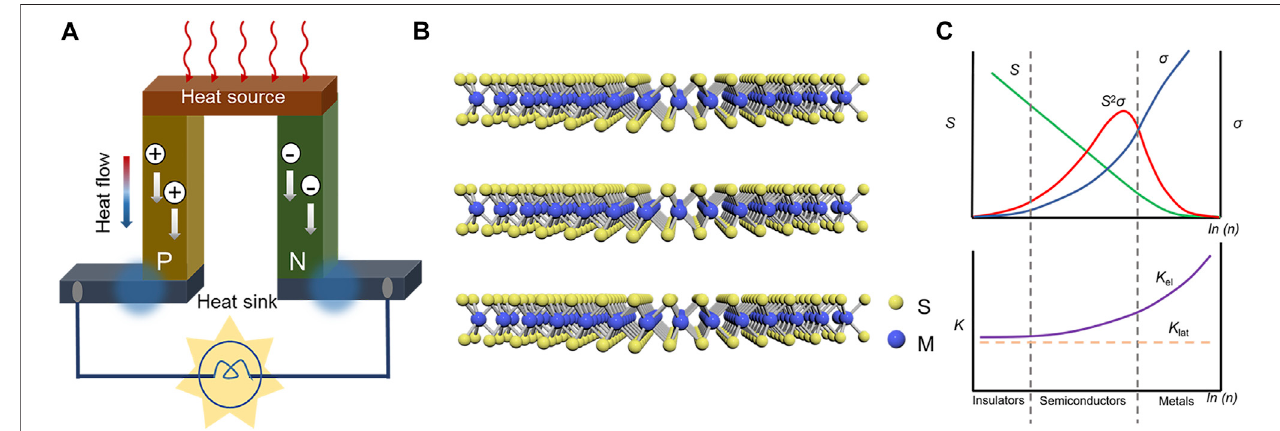
FIGURE 1 | (A) Schematic illustration of the TE device base on Seebeck effect. (B) Schematic representation of a layered TMD structure with the formula MX 2 , whereMisthetransitionmetalatomand Xisthechalcogenatom. (C) Interdependentrelation ofSeebeckcoef fi cient ( S ),electricalconductivity( σ ),andtheelectronic( κ el ) and lattice ( κ lat ) thermal conductivity for different charge carrier